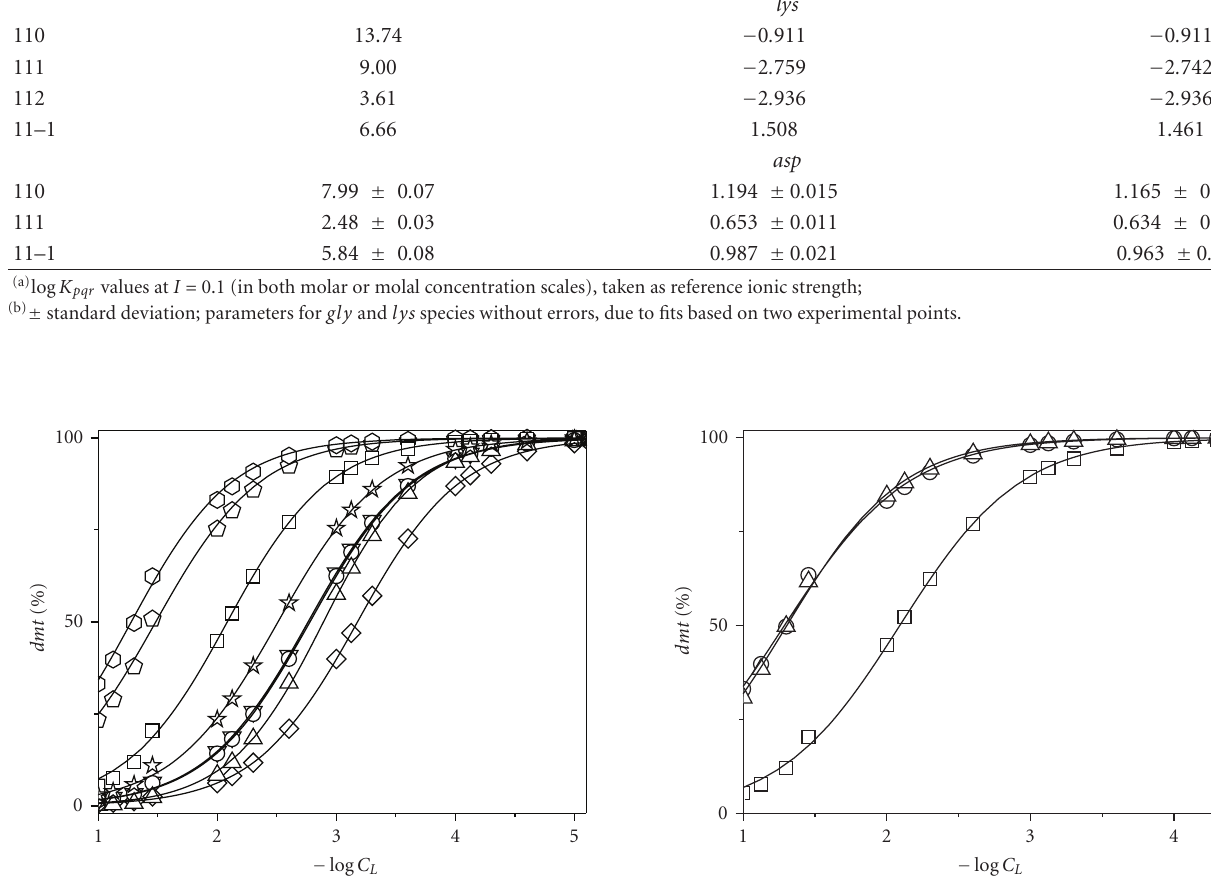
Figure 5: Dimethyltin(IV) sequestration diagrams in presence of ethylenediamine, glycinate, or malonate. Percentage of noncom- plexed dmt as a function of total ligand concentration (as − log C L ) at I = 0 . 1 mol L − 1 in NaCl aq and pH = 6.5. Total concentration of dmt , C dmt = 10 − 9 mol L − 1 . Symbols: : en; :